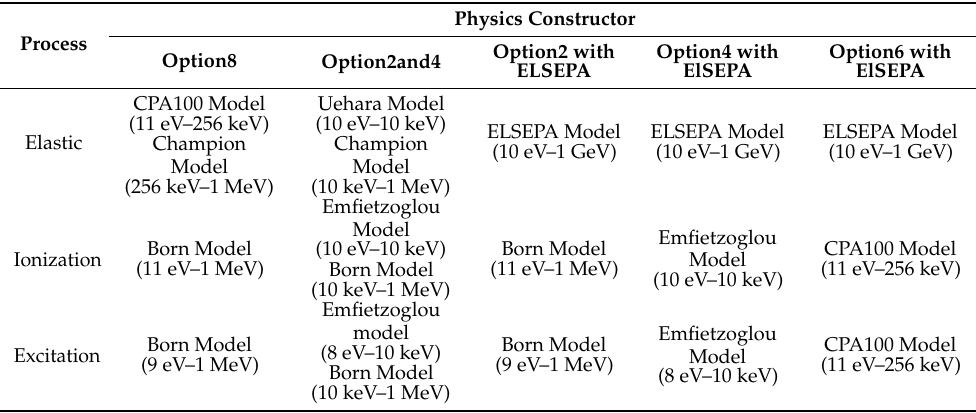
Figure 2. Range simulations in water with different physics constructors as a function of primary electron energy from 10 eV to 1 MeV. ( a ) MCTS simulations of the total path length as a function of incident electron energy compared with the other MC simulations data adapted from Ref. [64] Wiklund et al., 2009, and Ref. [65] Wilson et al., 2014, and continuous-slowing-down-approximation (CSDA) methods data adapted from Ref. [66] Watt et al., 2004, and Ref. [67] Seltzer et al., 2016. ( b ) Variation of the electron penetration range in comparison with data adapted from Ref. [68] Meesungnoen et al., 2002, Ref. [69] Uehara et al., 2006, and Ref. [63] Emfietzoglou et al., 2017. Table 1. Elastic and inelastic models of option8 in Geant4-DNA, the option with the ELSEPA model and the G4EmDNAPhysics_hybrid2and4 and energy limits of